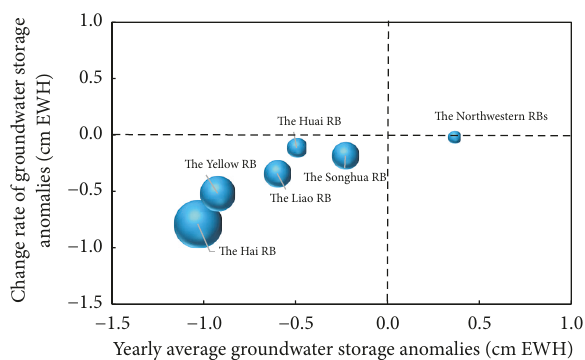
Figure 9: Changing trends of groundwater storage for the six river basins in Northern China from 2003 to